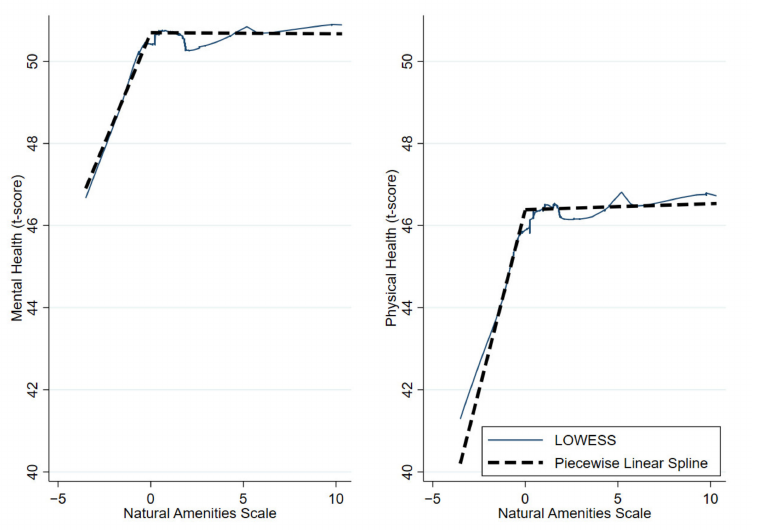
Figure 1. LOWESS curves and piecewise linear splines visualizing the unadjusted relationships among NAS and mental and physical